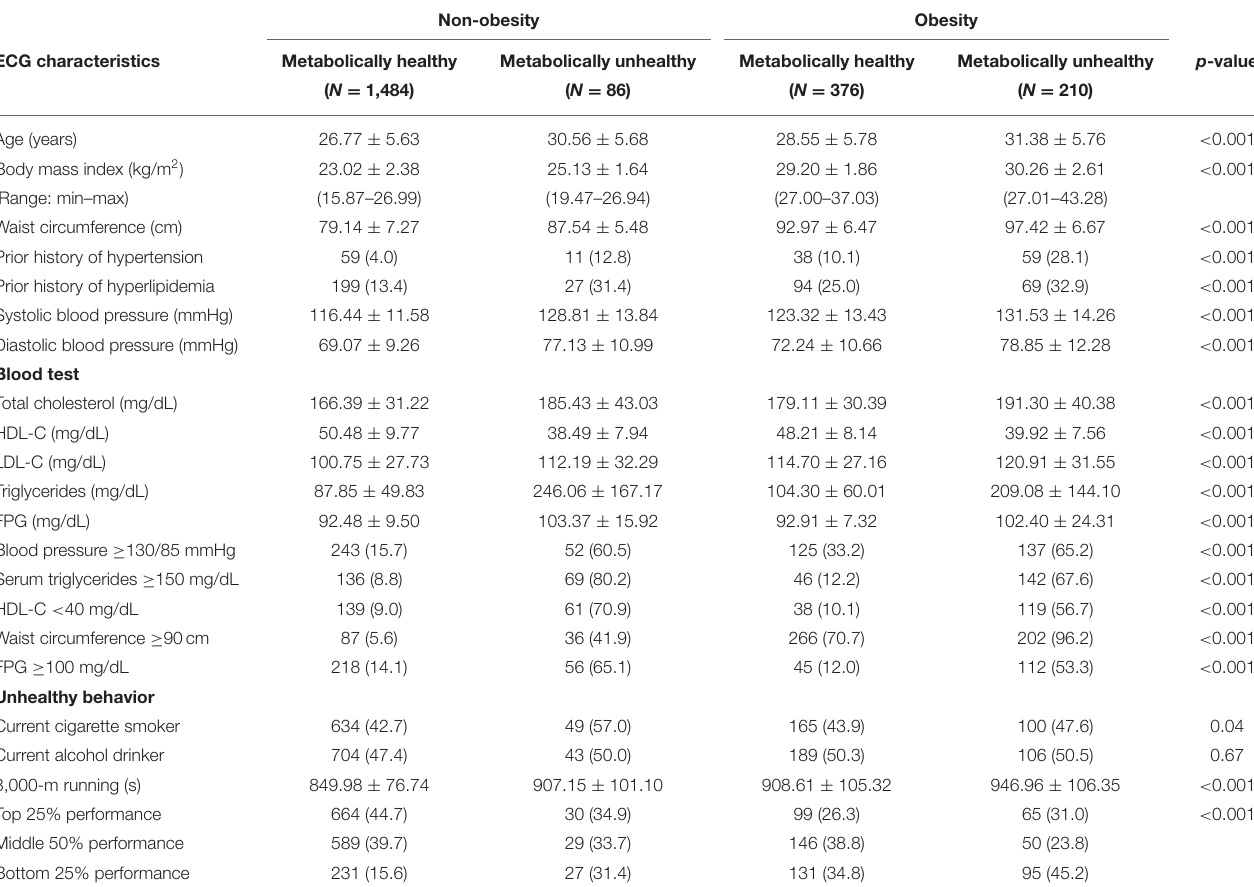
TABLE 1 | Clinical characteristics of four obesity phenotypes classified by body mass index and metabolic